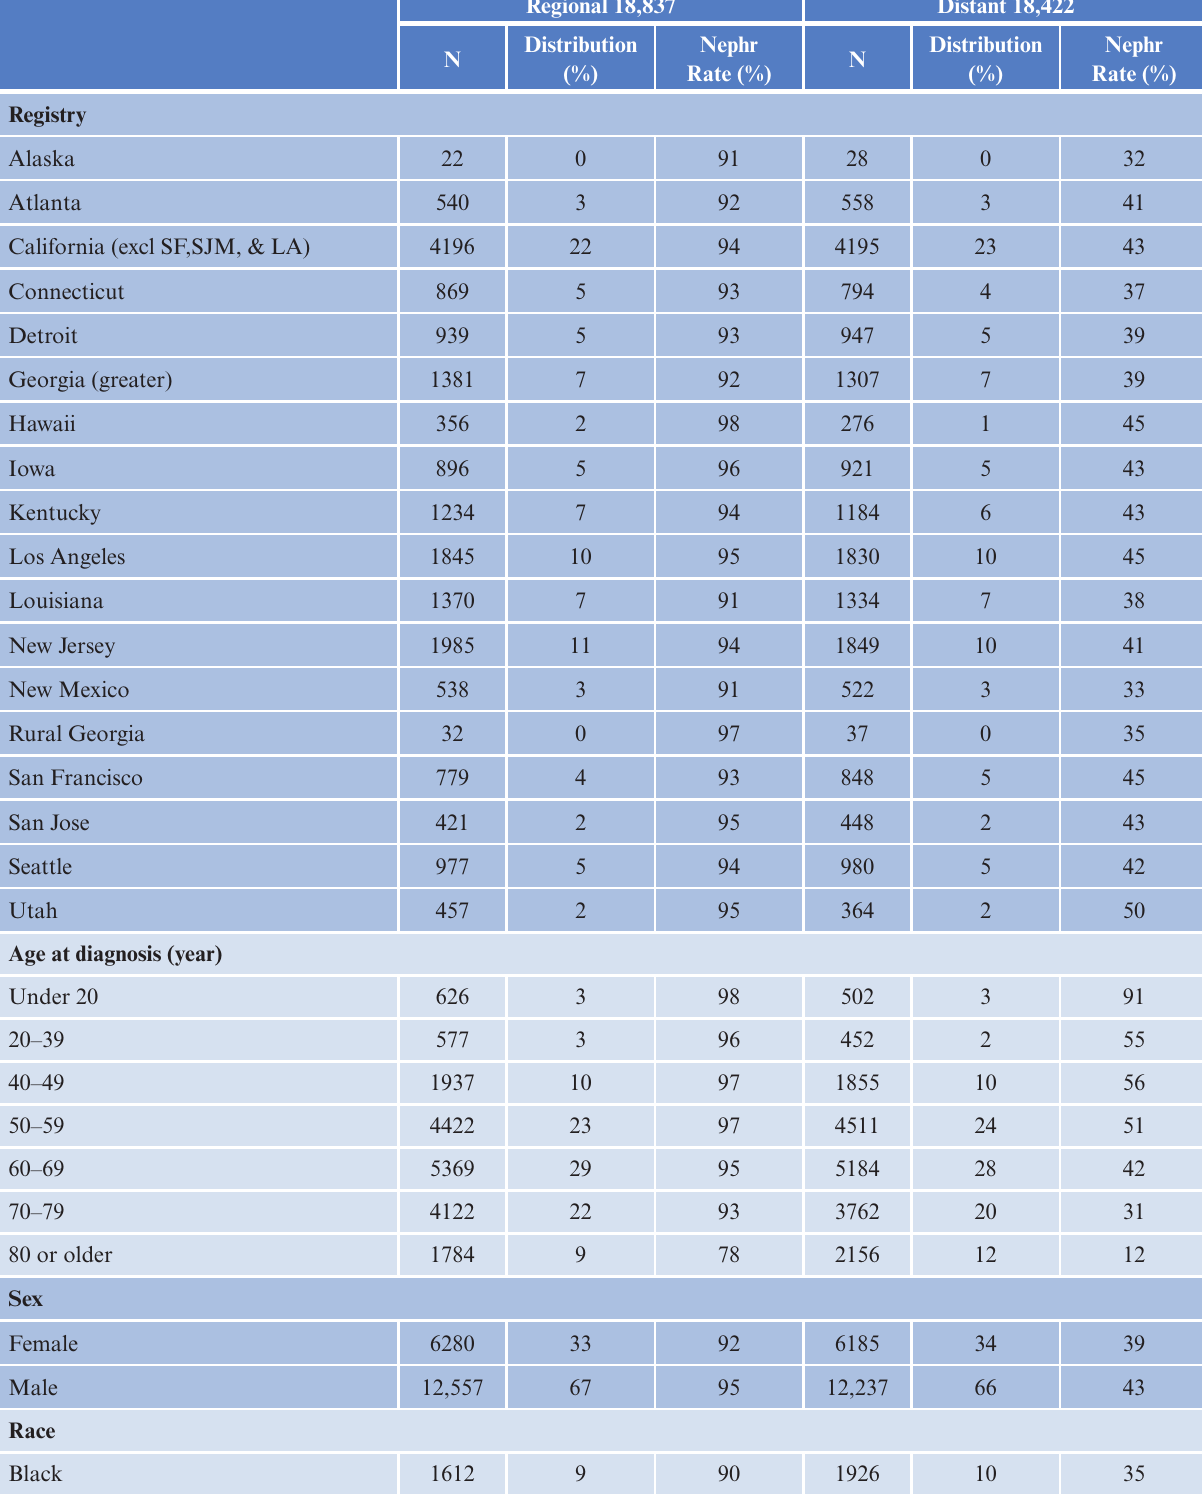
Table 1: Population Characteristics and Nephrectomy Rates of All SEER Kidney Cancer, Regional or Distant Stage: